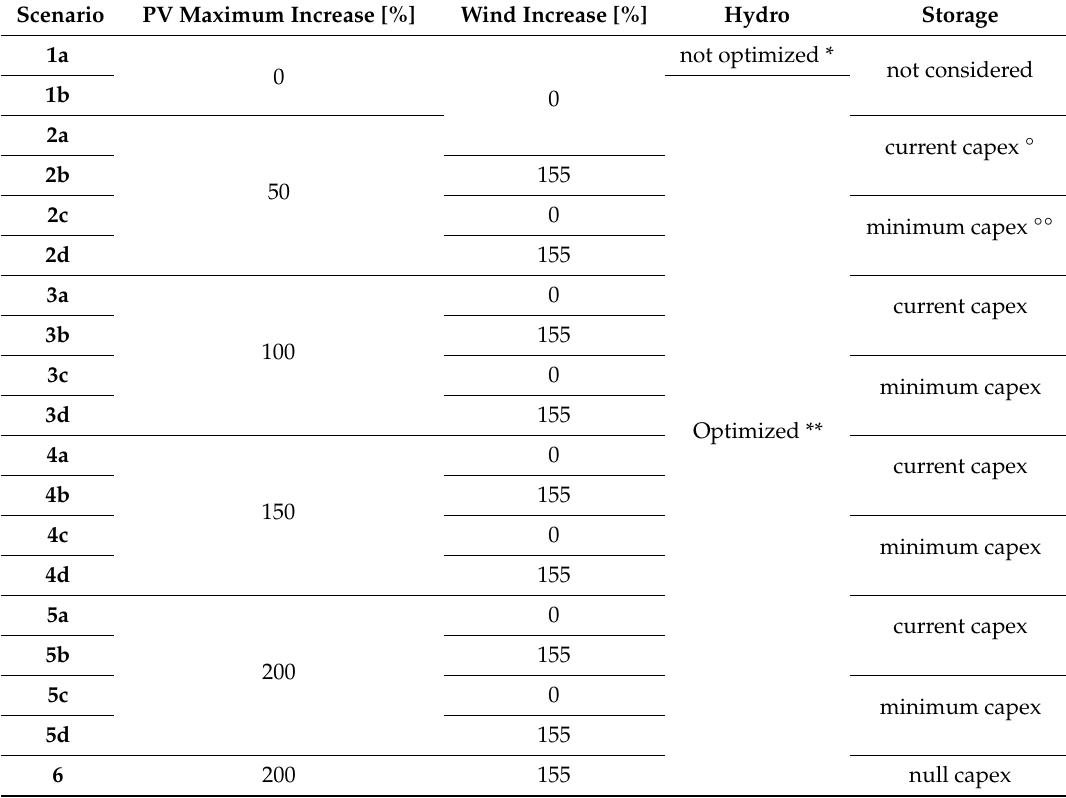
Table 4. List of